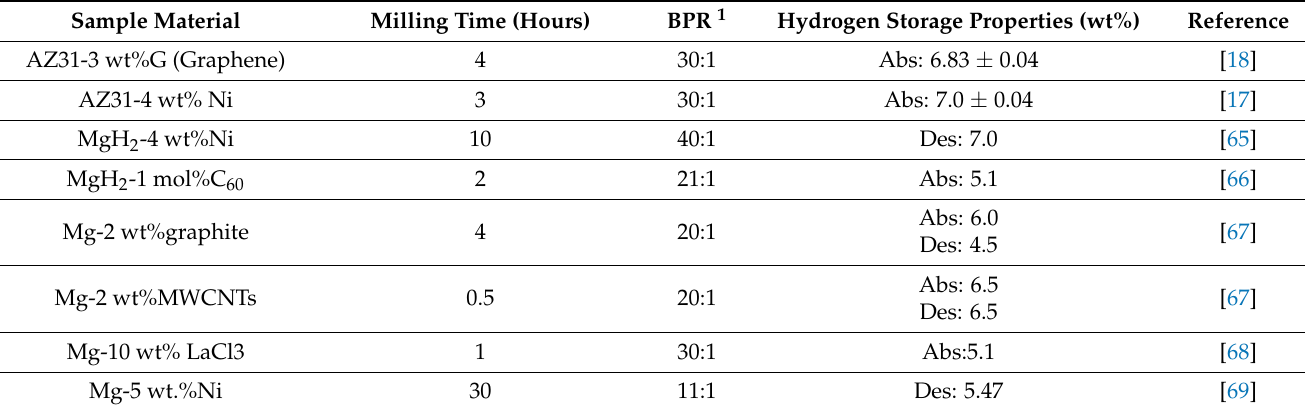
Table 3. Different processing parameters for ball milling in the hydrogen absorption of Mg-composites. Sample